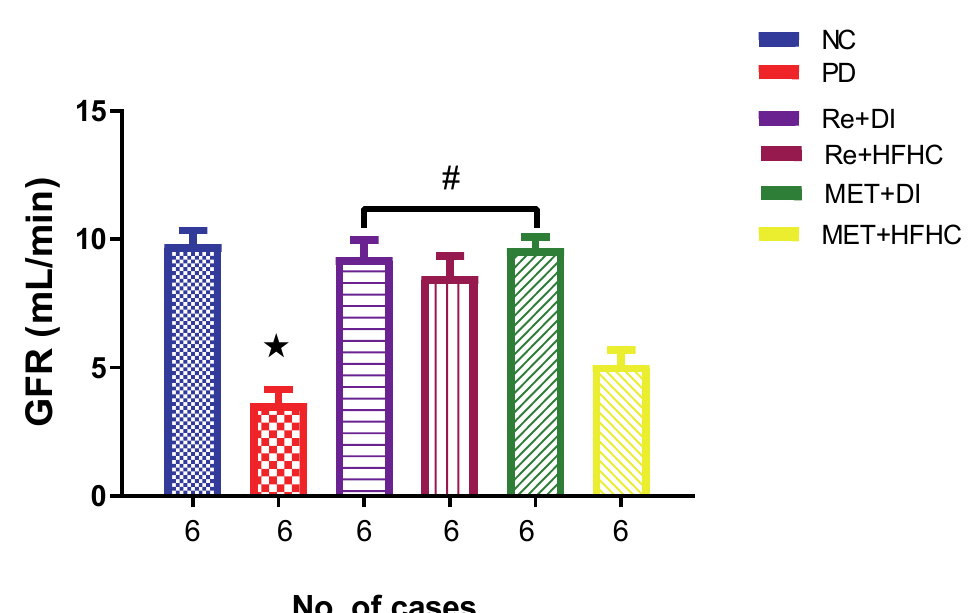
Figure 9. GFR in normal control (NC), prediabetic control (PD), metformin and diet intervention (MET + DI), metformin and high-fat/high-carbohydrate diet (MET + HFHC), rhenium (V) compound and diet intervention (Re + DI) and rhenium (V) compound and high-fat/high-carbohydrate diet (Re + HFHC) groups after 12 weeks of treatment. Values are presented as means ± SEM (n = 6). (cid:70) p < 0.05 in comparison with NC; # p < 0.05 in comparison with PC, MET + DI, MET + HFHC, Re + DI and Re + HFHC.